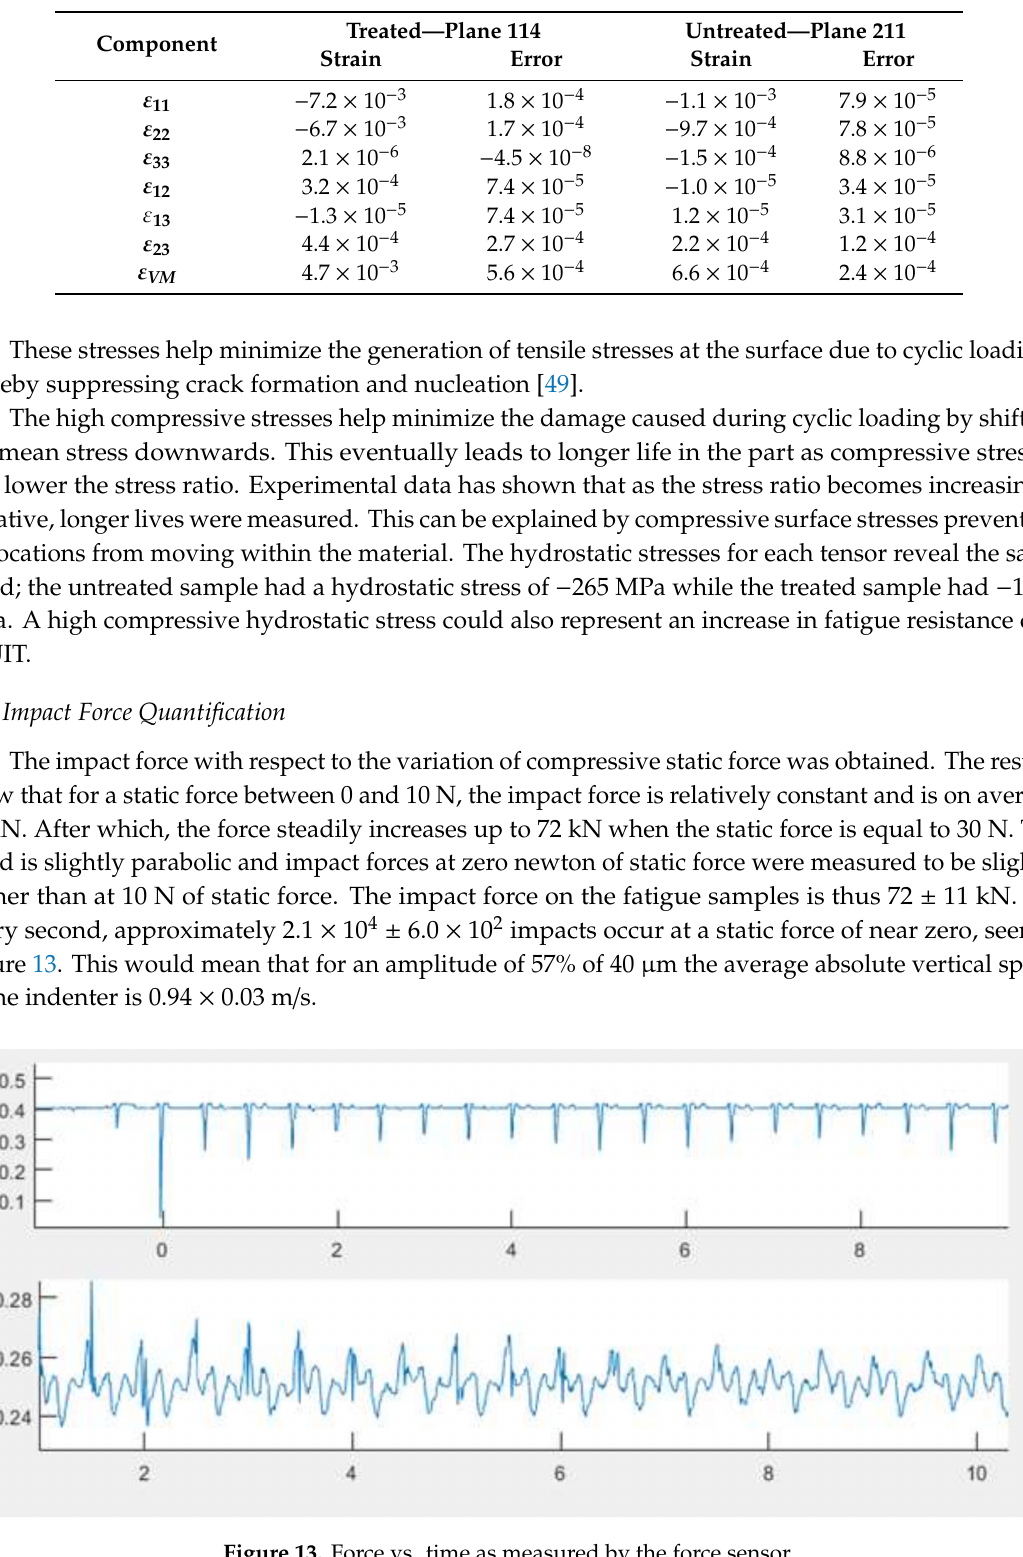
Figure 13. Force vs. time as measured by the force